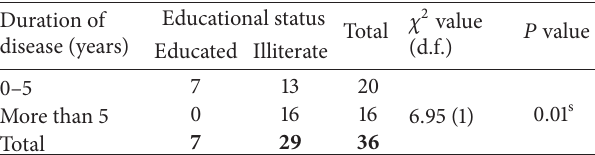
Table 2: Association between duration of disease and educational